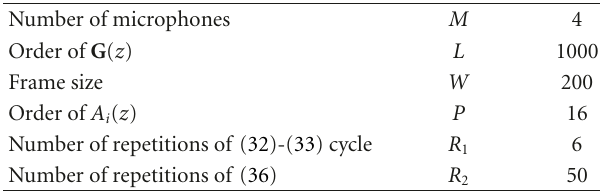
Table 2: Parameter settings. Each optimization (32) is realized by LP whereas each (33) is implemented by repeating